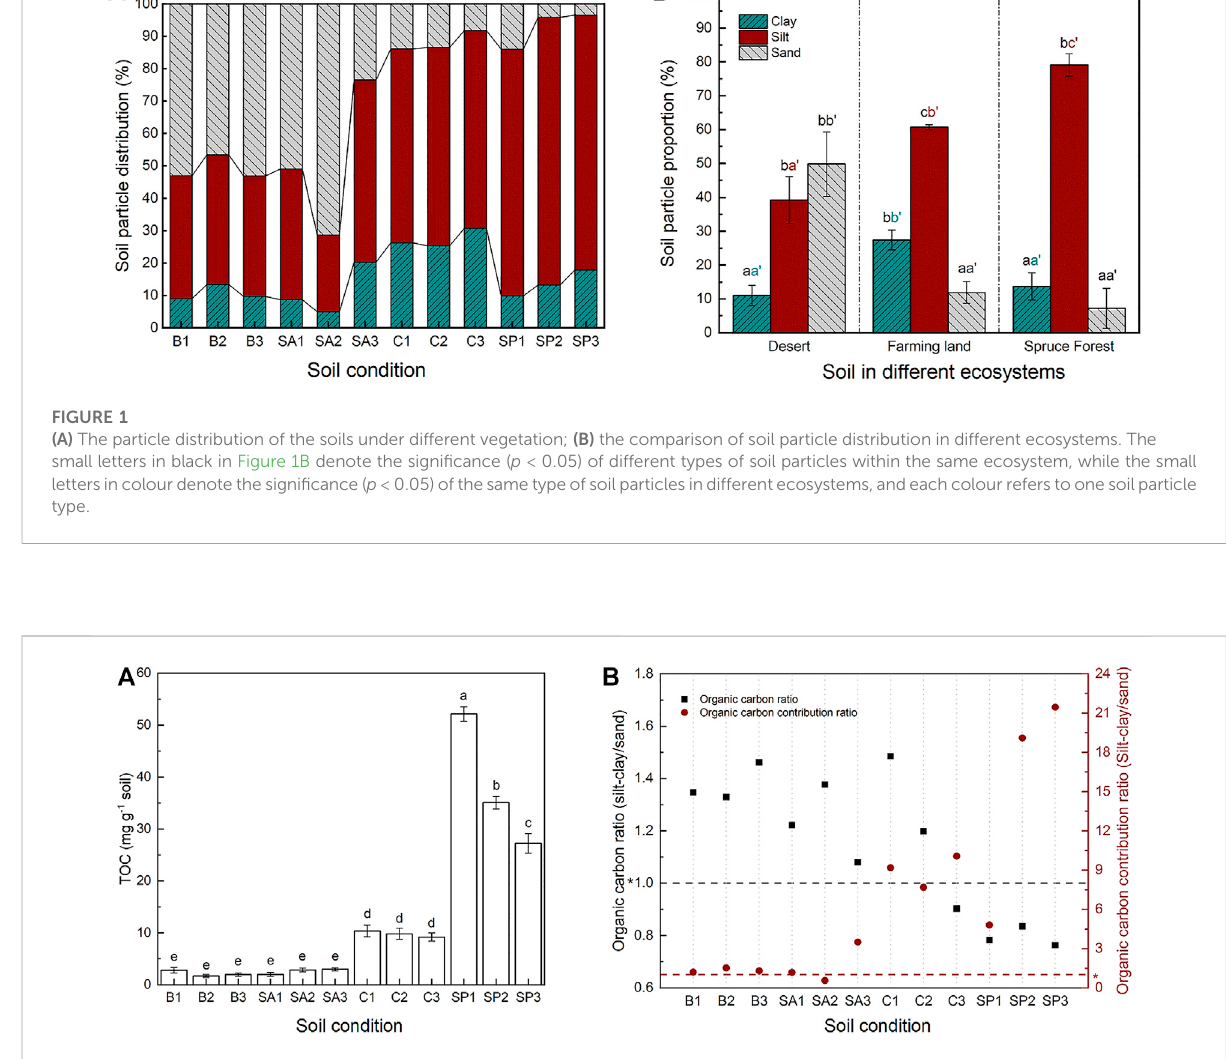
FIGURE 2 (A) The organic carbon content of the soil (SOC) under different vegetation; (B) the ratio of the organic carbon content of silt-clay and sand fractions (left Y -axis) and the ratio of organic carbon contribution of soil particle fractions to soil for silt-clay and sand fractions (right Y -axis).